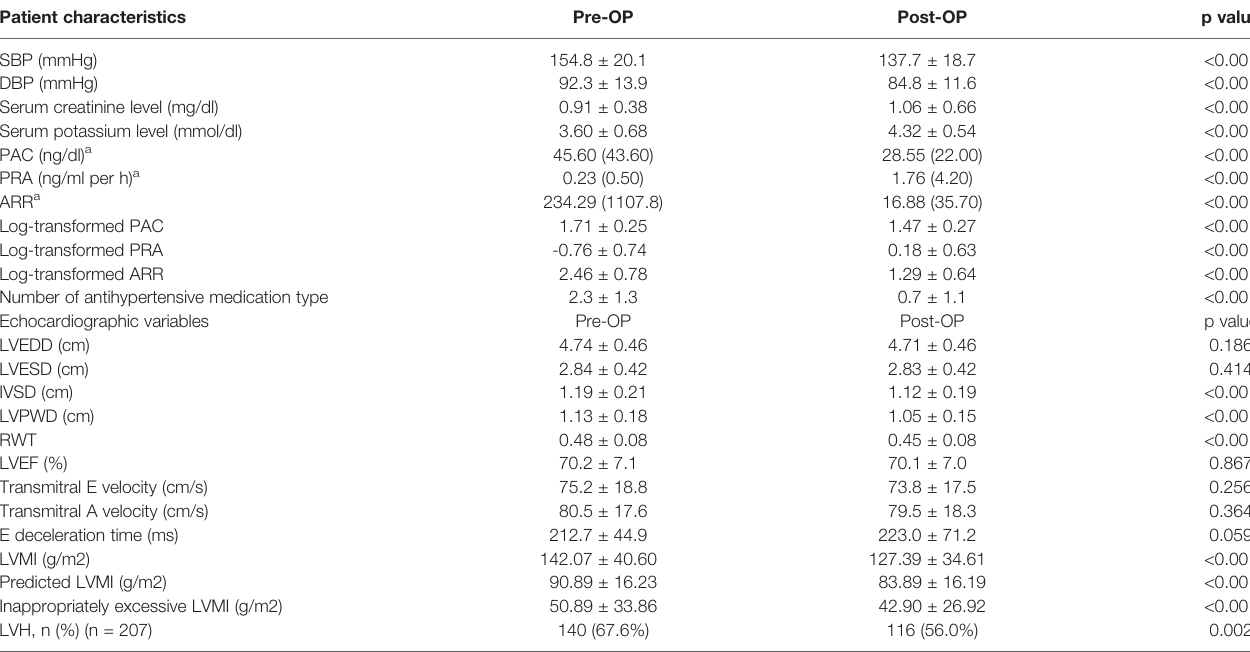
TABLE 4 | Clinical characteristics, echocardiographic features, doppler-derived indexes, and change of patients with primary aldosteronism receiving adrenalectomy. Patient characteristics